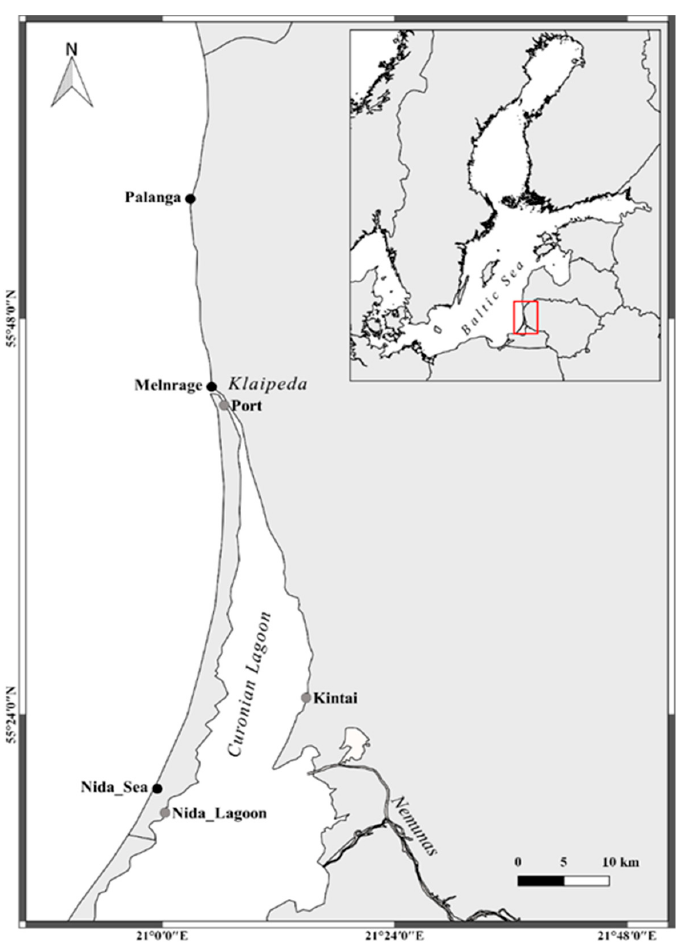
Figure 1. Locations of Lithuanian Baltic Sea coastal bathing sites (black points) and Curonian Lagoon sites (grey points).